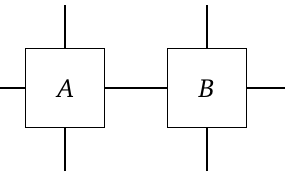
Figure 1: Two tensors are shown in Penrose notation. This network specifies a single contraction over a single pair of indices between the two tensors, as well as several external indices on each.